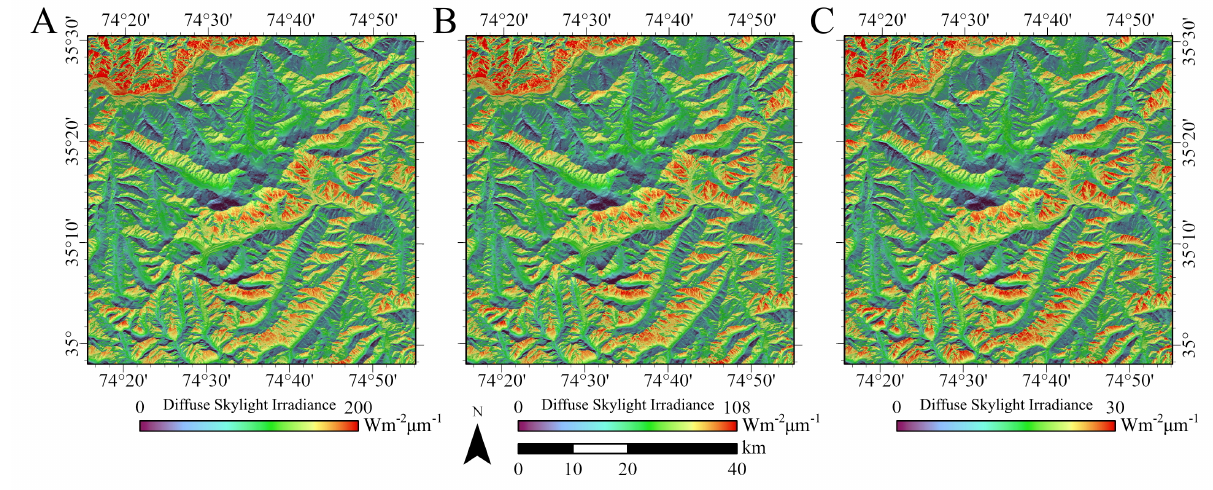
Figure 5. Diffuse-skylight irradiance simulation results over the Nanga Parbat Massif on 15 September 2022 at 10:00 a.m. ( A ). The green portion of the electromagnetic spectrum ( λ = 0.56141 µ m). ( B ). The red portion of the electromagnetic spectrum ( λ = 0.65459 µ m). ( C ). The near-infrared portion of the electromagnetic spectrum ( λ = 0.86467 µ m). The irradiance is superimposed over cos i using 50-percent